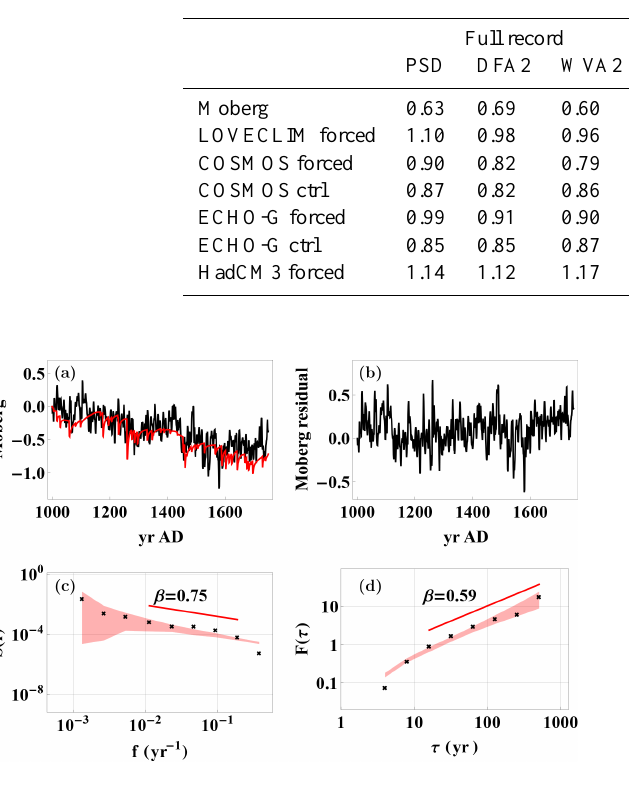
Figure 3. (a) The Moberg reconstructed temperature (black) and the deterministic response (red). (b) The residual from the deter- ministic response. (c) PSD from the residual (black crosses) and linear fit to the PSD in the scale range indicated by the red line seg- ment. The value β = 0 . 75 estimated from this line segment is indi- cated in the figure. (d) DFA2 applied to the residual (black crosses). The straight line segment is a linear fit to the dots in the range indi- cated by the length, and position of the line segment and the slope yields an alternative estimate β = 0 . 59 for the residual, indicated in the figure. The shaded area in (c) and (d) is the 95% confidence range for synthetic fGn with β = 0 . 75 estimated by MLE using the response model.